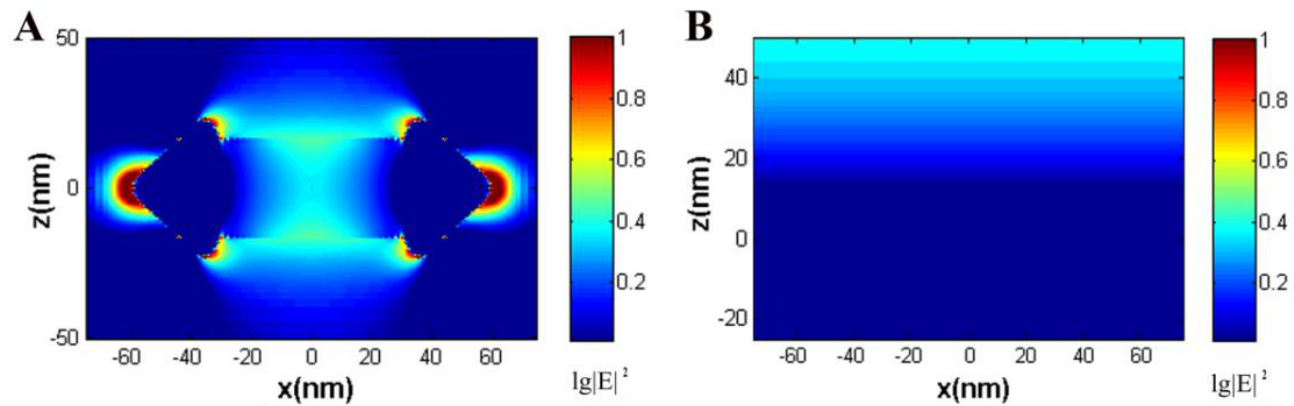
Figure 2. FDTD simulation results of the near field at 561 nm for ( A ) a single Au-Ag NS and ( B ) bare Au substrate.